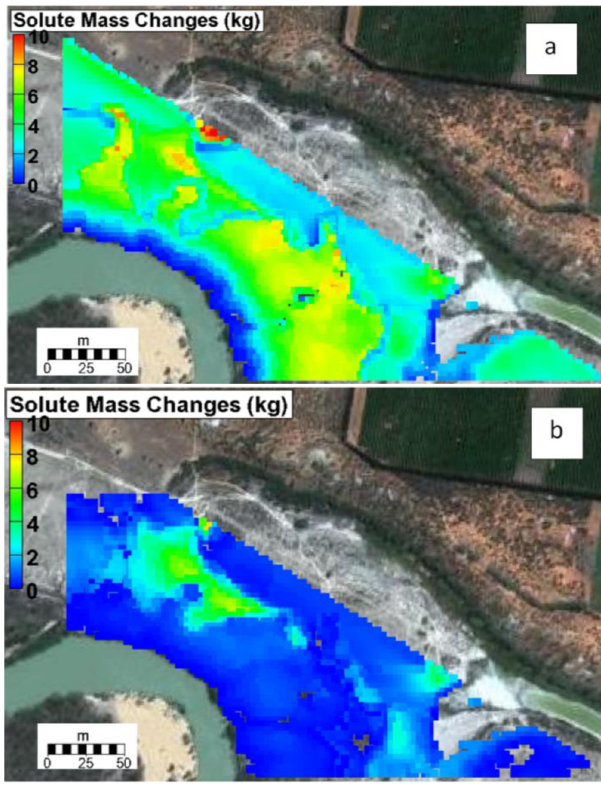
Fig. 14. 3-D visualization of solute mass changes in the unsaturated zone for the defined scenarios; (a) amount of solute mass removed from the unsaturated zone during the with-SIS scenario, (b) amount of solute mass that could be stored in the system if SIS was not installed on the